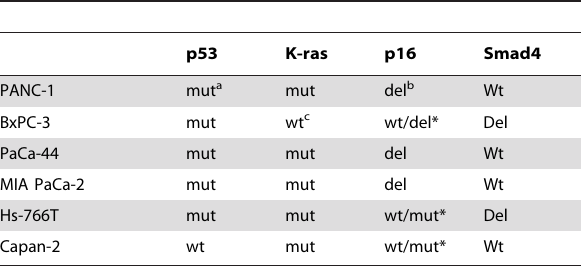
Table 1. Molecular alterations of tumor-associated markers in human pancreatic tumor cell lines (based on